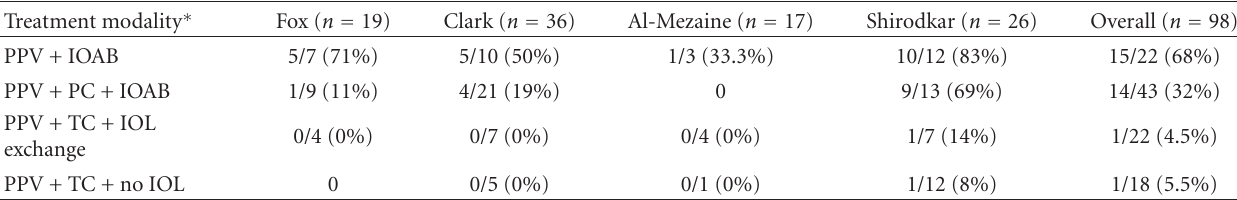
Table 6: Recurrence rate of chronic post operative endophthalmitis with di ff erent surgical interventions [5, 16, 18,